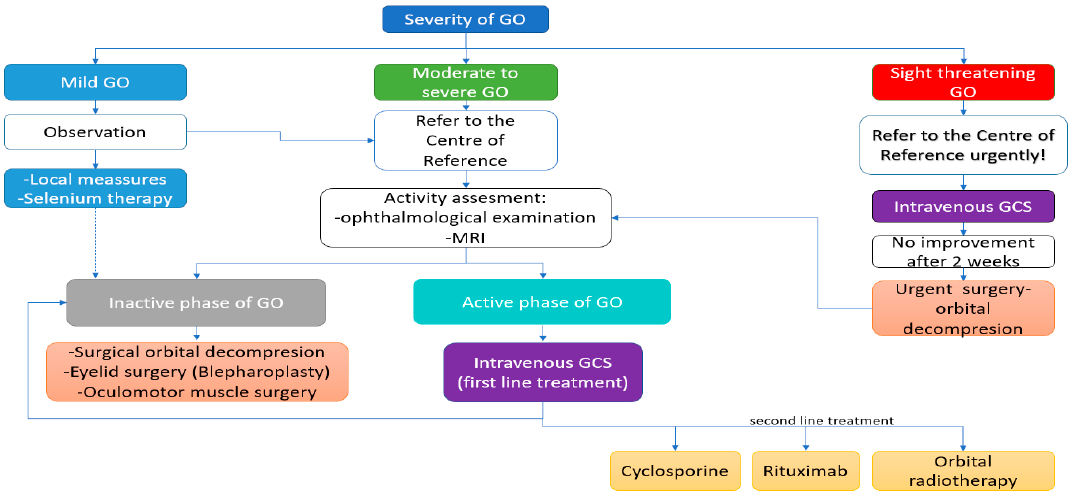
Figure 5. The management of GO (Graves’ Orbitopathy) depending on the disease severity and activity according to EUGOGO (The European Group on Graves’ Orbitopathy) guidelines [53]. MRI: magnetic resonance imaging, GCS: Glucocorticoids.